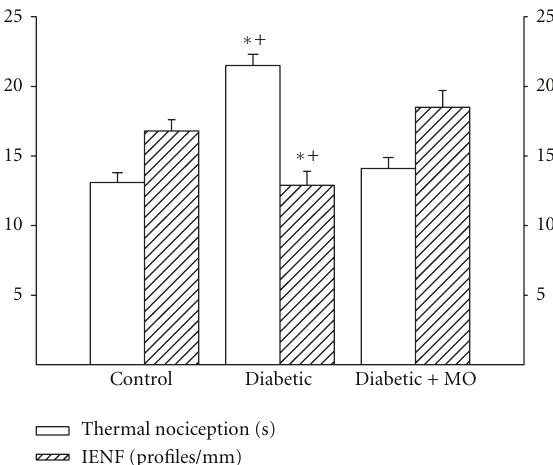
Figure 4: E ff ect of treatment of high-fat/streptozotocin diabetic rats with menhaden-oil- (MO-) supplemented diet on thermal nociception and intraepidermal nerve fiber density. Thermal noci- ception and intraepidermal nerve fiber density was examined as described in Section 2. Data are presented as the mean ± S.E.M. for thermal nociception in sec and intraepidermal nerve fiber profiles per mm. The number of rats in each group was the same as shown in Table 2. ∗ P < 0 . 05 compared to control rats; + P < 0 . 05 compared to diabetic